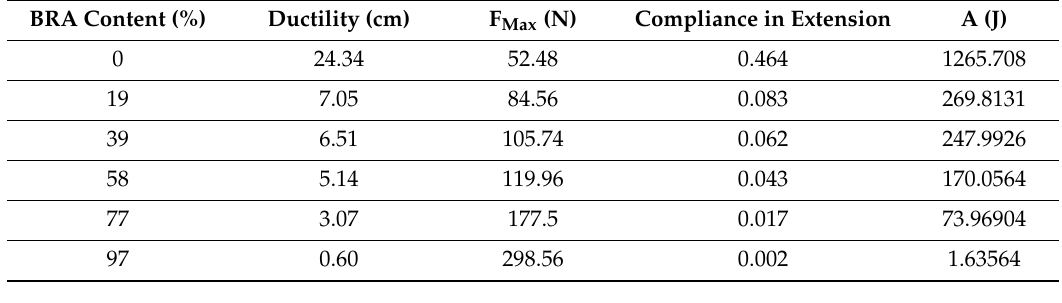
Table 11. Force ductility test result of BRA-modified asphalt. Figure 3. Relationship between tensile force and ductility of BRA-modified asphalt.